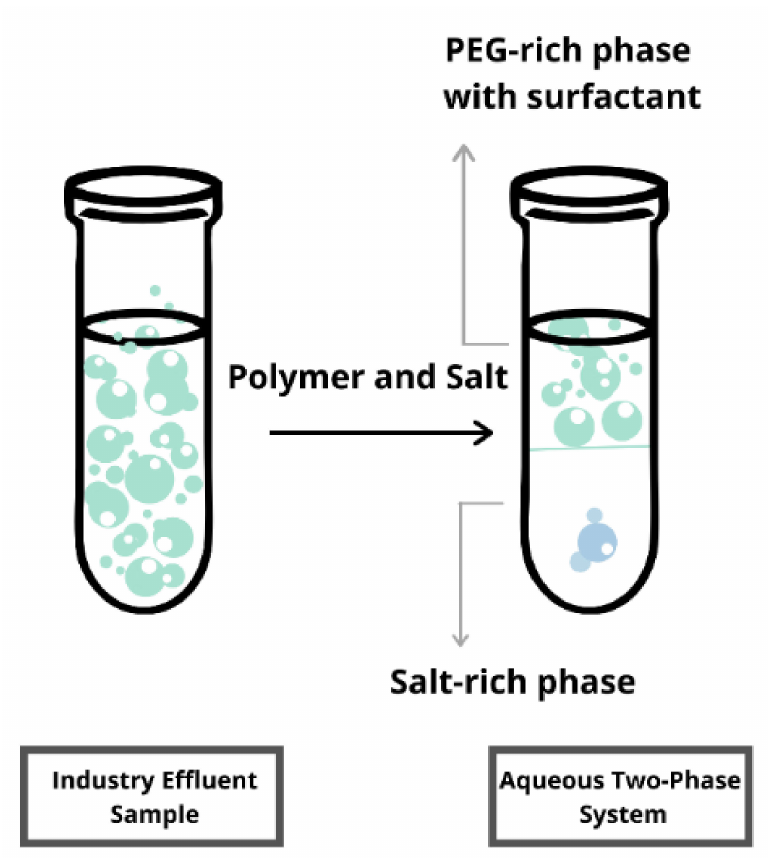
Figure 1. Graphical image of the liquid biphasic